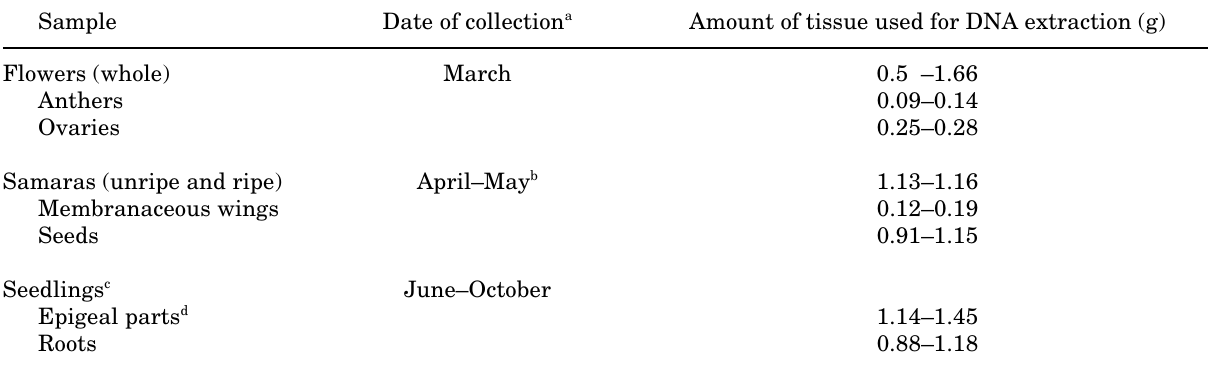
Table 1. Plant tissues examined in this study, sampled at different times of year, with the amounts used for DNA extraction. For each tissue, samples were collected from the two Lobel hybrid clones, and from Ulmus laevis and U . japonica